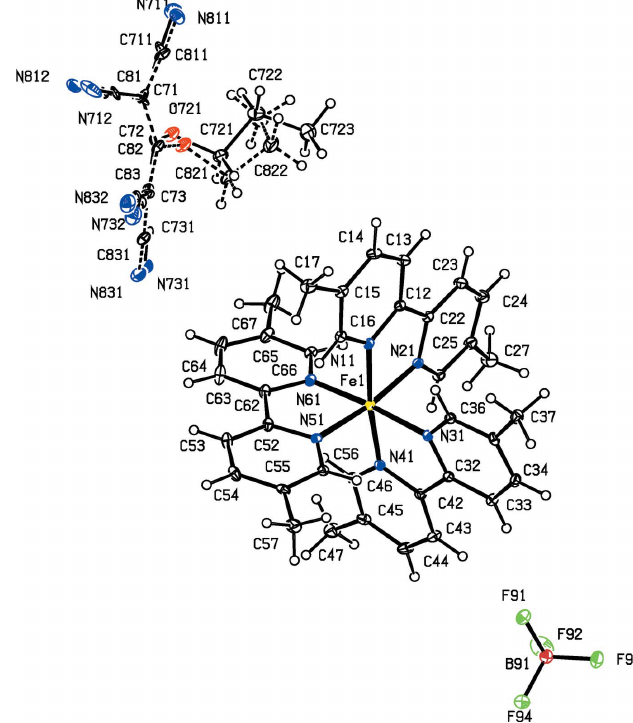
Figure 6 The independent ionic components in compound (VI), showing the atom- labelling scheme. Displacement ellipsoids are drawn at the 30% probability level.